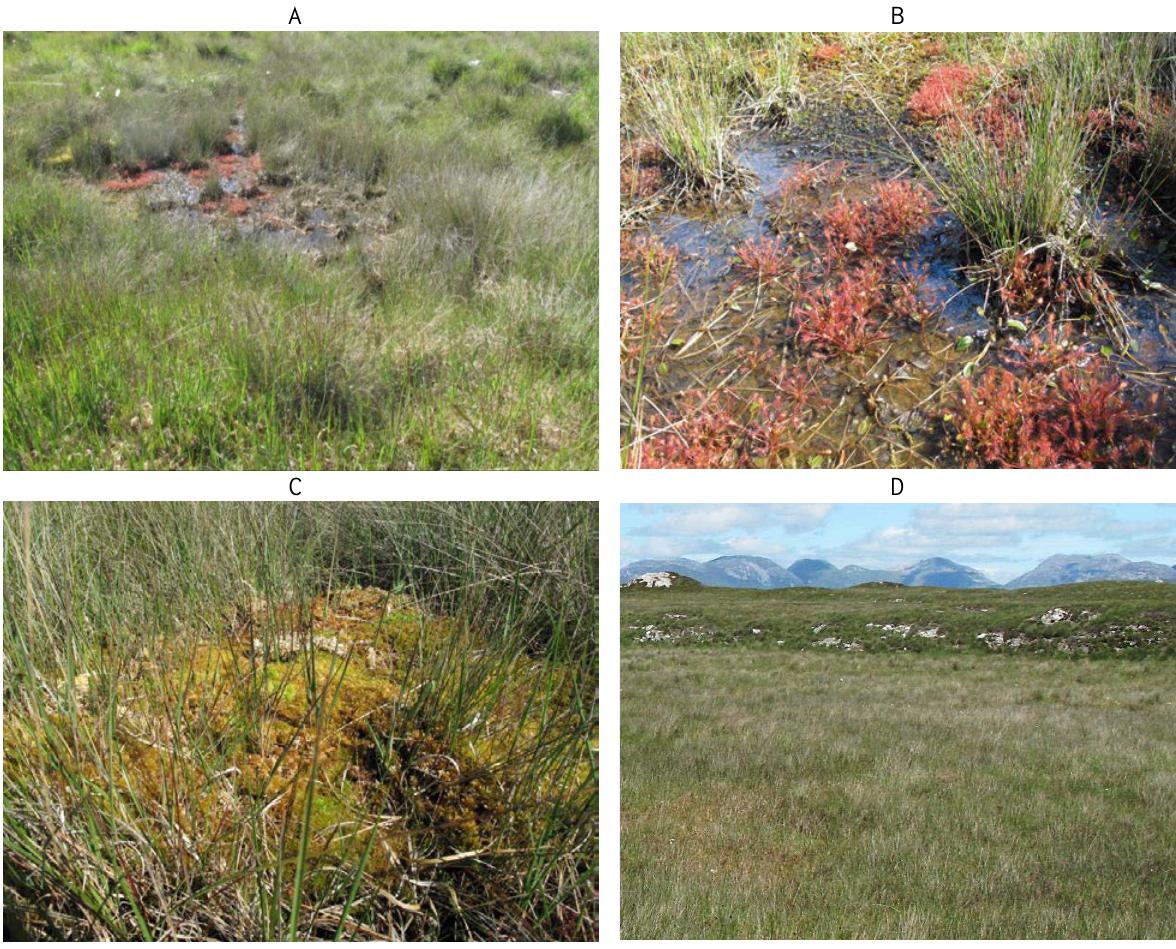
Figure 4. Photographs of the main vegetation types in the Roundstone Bog study area. A and B: open patches with Drosera rotundifolia and Potamogeton polygonifolius ; C: Sphagnum -dominated bog vegetation with Schoenus nigricans and Molinia caerulea ; D: wet heath with S. nigricans (foreground) and dry heath (on rock